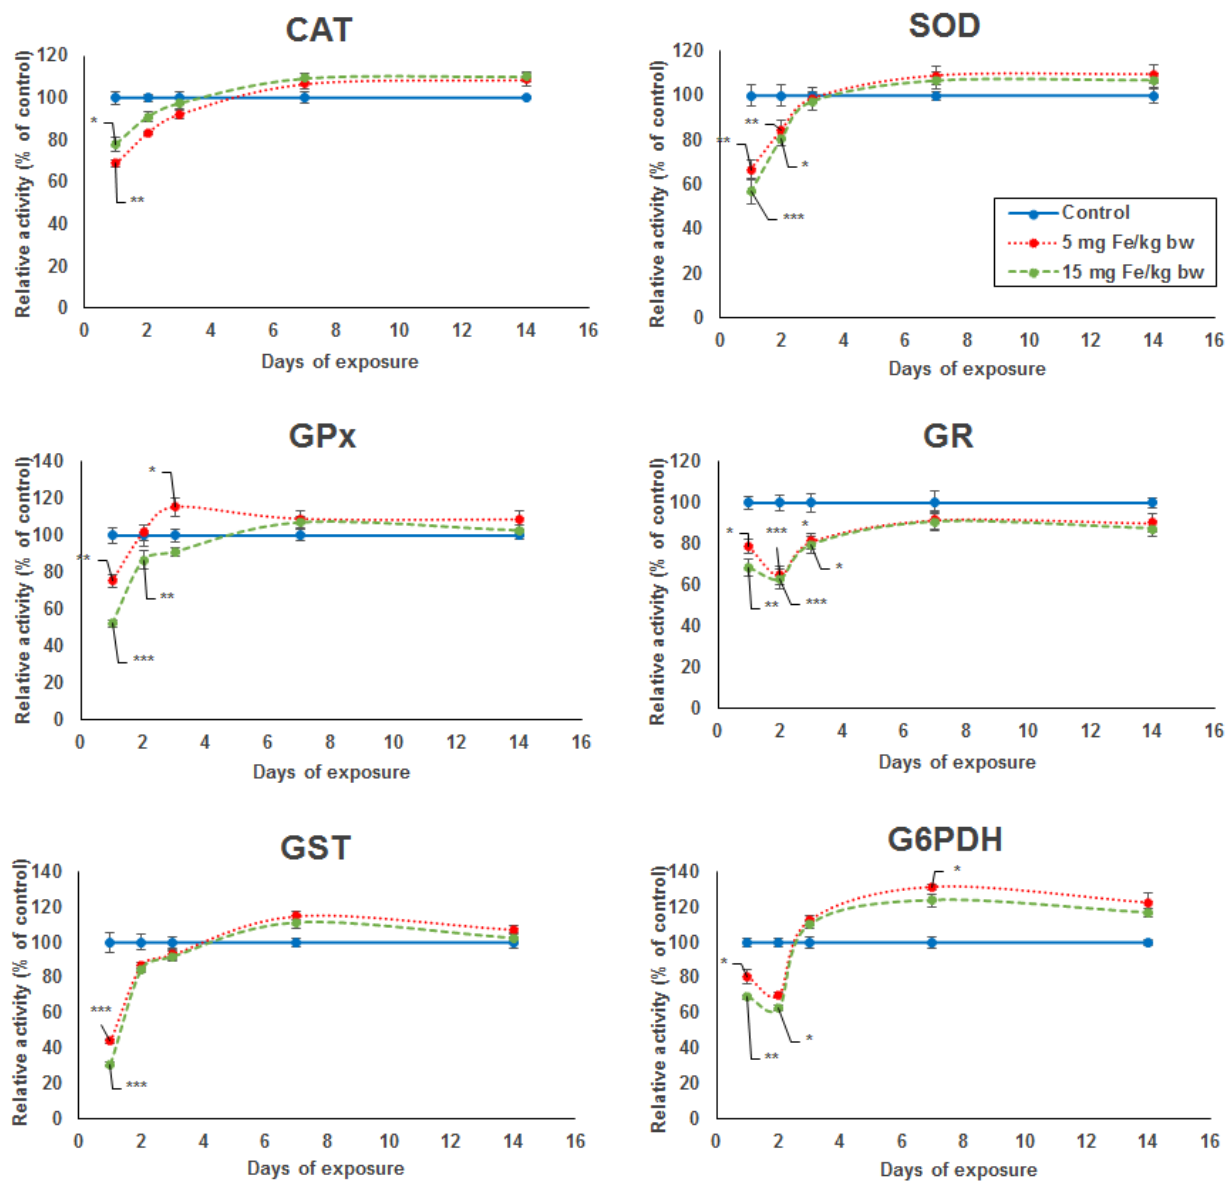
Figure 1. Variation in enzymatic activity of CAT, SOD, GPx, GR, GST, and G6PDH from kidneys’ tissue extracts of CD1 mice treated with 5 and 15 mg of Fe/kg body weight (bw) of IONPs encapsulated in phospholipid-based micelles at 1, 2, 3, 7, and 14 days post-administration. The values refer to the mean ± standard deviation (SD) and are expressed as percentages of control; the results were considered statistically significant when * p < 0.05; ** p < 0.01; *** p < 0.001 versus the control group.